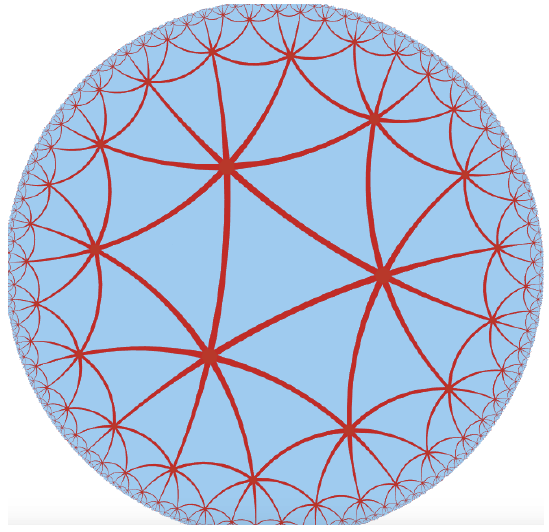
Figure 9 . The triangulation of H 2 with Schl(cid:127)a(cid:13)i symbol f 3 ; 8 g . There are triangular cells in the tessellation which share edges with two triangles from the previous layer, and only one in the subsequent layer. Figure produced via the software [35].